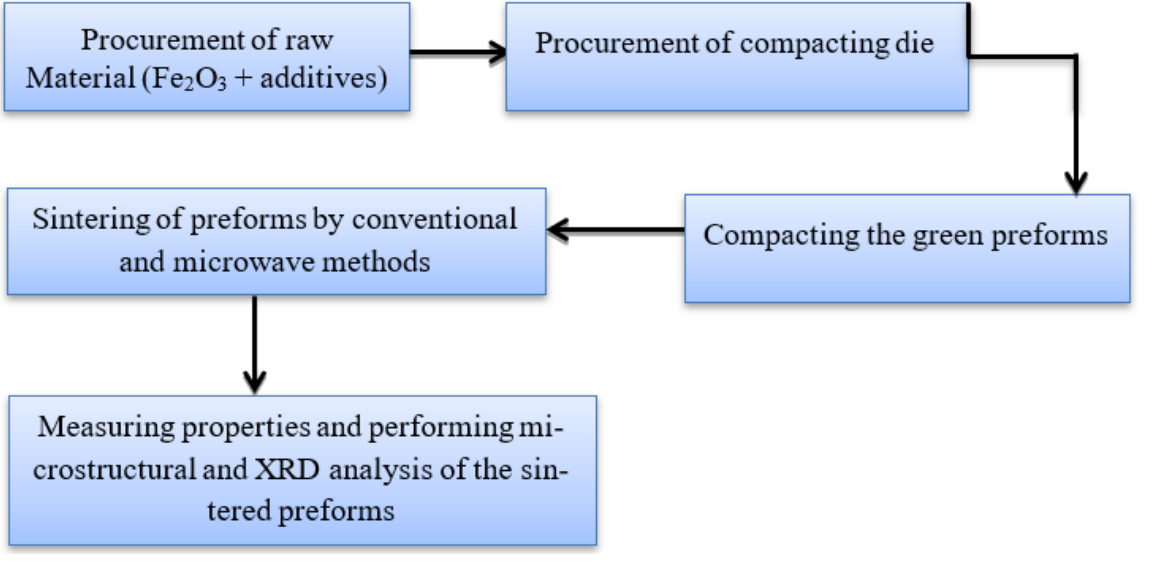
Figure 2. Workflow of investigation.